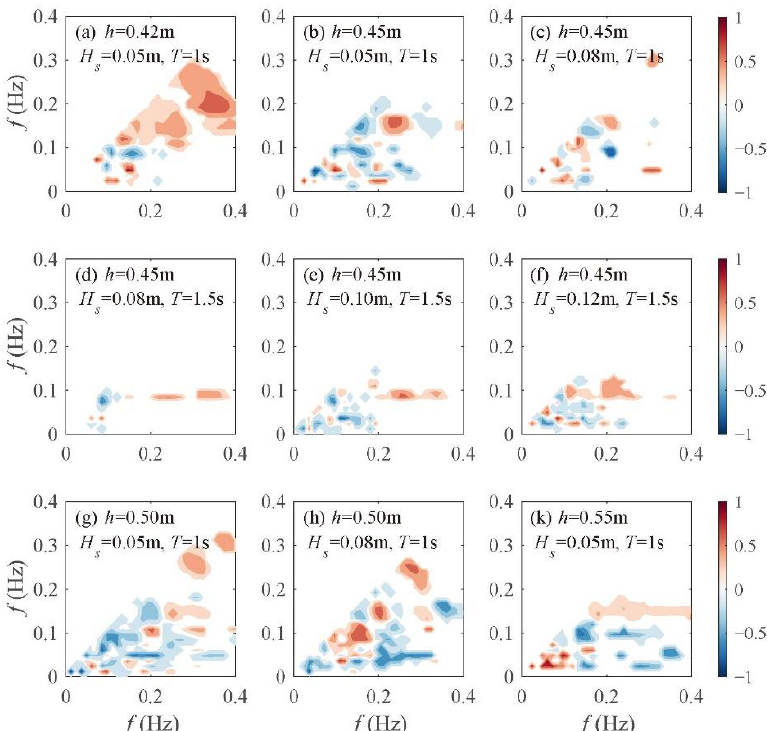
Figure 12. Imagery part of Swash bispectrum of different experiment conditions: ( a ) T00, ( b ) T01, ( c ) T02, ( d ) T03, ( e ) T04, ( f ) T05, ( g ) T06, ( h ) T07, ( k ) T11. Xlabel and Ylabel are wave components frequency. Colorbar denotes the imagery part of swash bispectrum value.